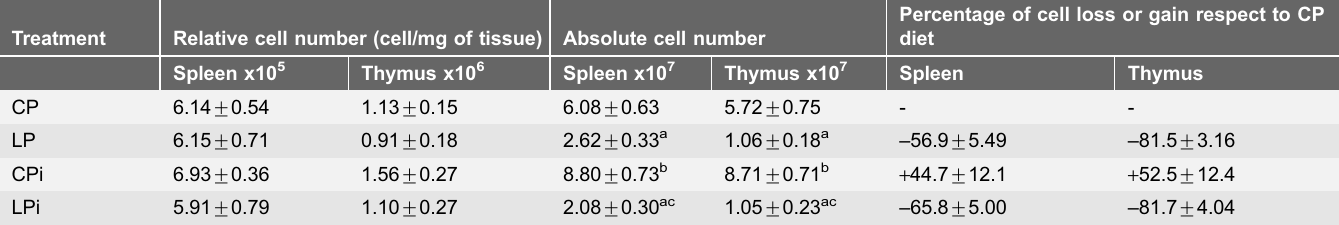
CP: animals fed 14% protein diet; LP: animals fed 4% protein diet, CPi: animals fed 14% protein diet and infected; LPi: animals fed 4% protein diet and infected. Letters indicate statistical differences using a Two-way ANOVA analysis with Bonferroni pos-hoc test. Statistical differences due to diet: a (p , 0.001), infection: b (p , 0.05) and interaction between diet and infection: c (p ,